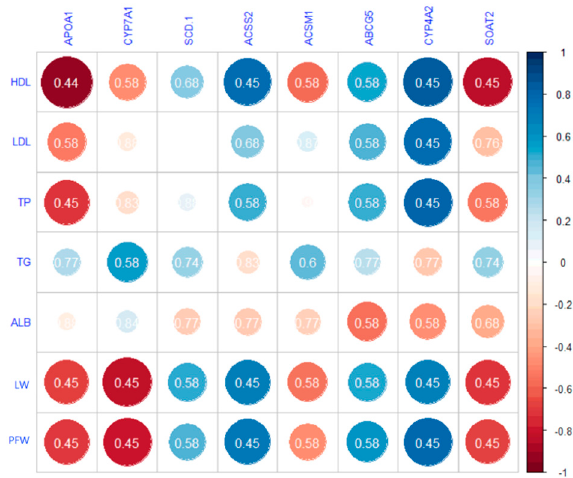
Figure 10. Pearson’s correlations between gene transcription and phenotypic traits. Size of the circle in the figure represents the correlation coefficient. Numbers in the circles represent p -values which are corrected by false discovery rate (FDR). HDL: high density lipoprotein; LDL: low density lipoprotein; TP: total protein; TG: triglycerides; ALB: albumin; LW: liver weight; PFW: perirenal fat weight.